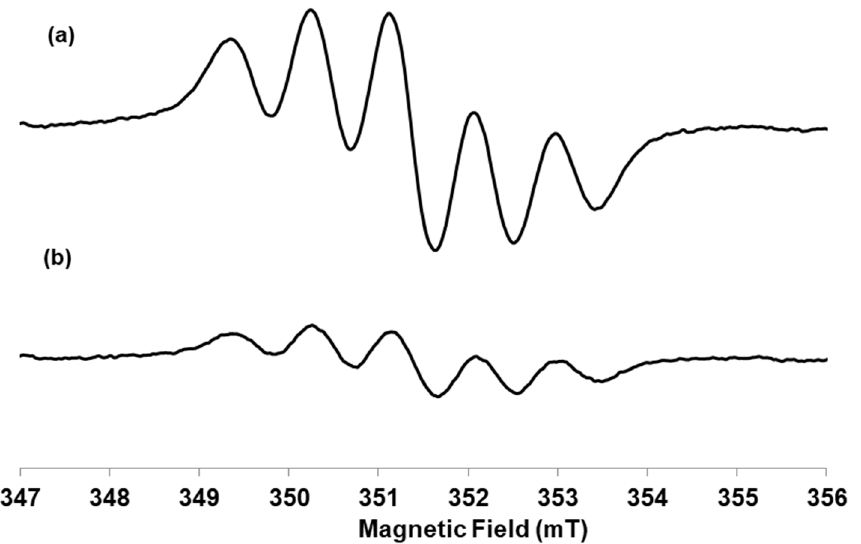
Figure 2. Room temperature X-band spectra of ( a ) DPPH radical alone, ( b ) DPPH radical after the addition of Rosmarinus officinalis extract. Experimental conditions: The spectra were recorded at microwave frequency ν = 9.86 GHz, microwave power 2 mW and 0.1 mT modulation amplitude.